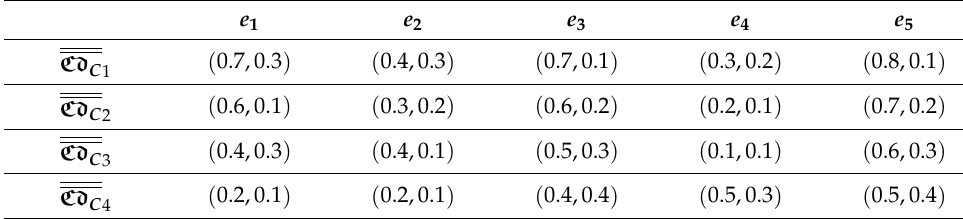
Table 1. Intuitionistic fuzzy soft matrix for Cd A 1 .